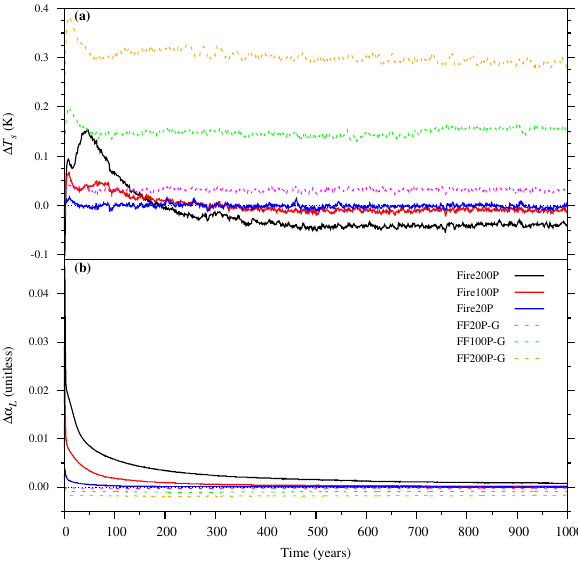
Figure 4. Changes in (a) global mean atmospheric surface tem- perature and (b) global mean land surface albedo from the pulse experiments. The fossil fuel emissions were set equal to gross fire